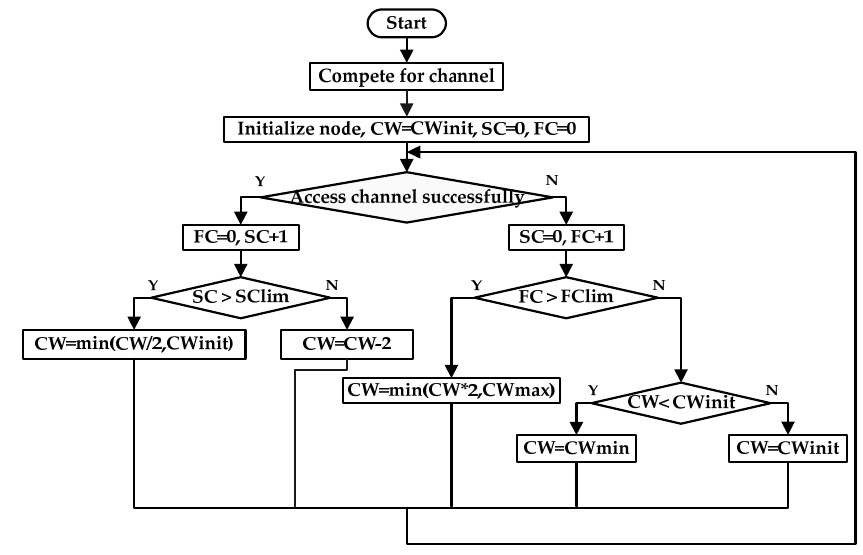
Figure 1. Flow chart for the improved backoff algorithm .